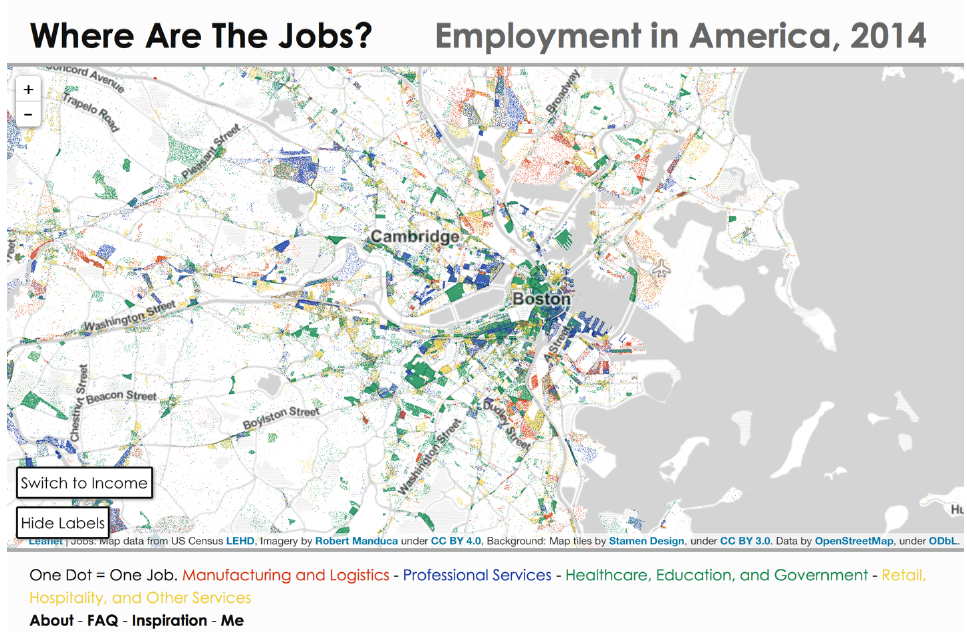
Figure 1: Screenshot from “Where Are the Jobs?”, a web visualization of the LODES Work- place Area Characteristics data (http://www.robertmanduca.com/projects/jobs.html) been increasing use of the LEHD data to study entrepreneurship (Goetz et al.